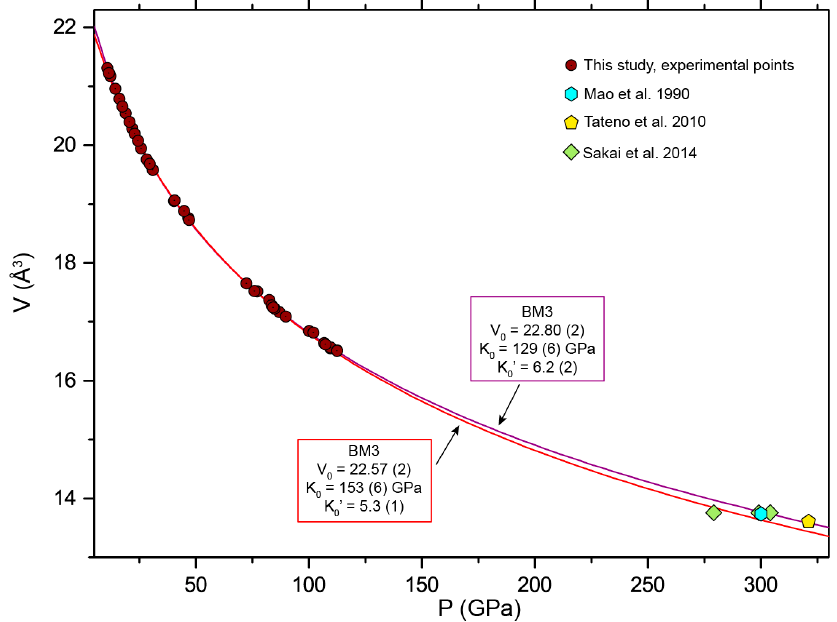
Figure 3. Extrapolation of the two room ‐ temperature equations of state discussed at pressures compatible with the experimental data from [6]. The experimental data from the present study are added as well.